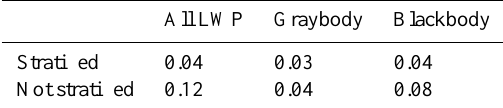
Table 6. Difference between ACI net τ and ACI net r graybody, blackbody, and all clouds when lower tropospheric stabil- ity and specific humidity are stratified and when they are not strati- fied. The averaged ACI net values are shown in Table